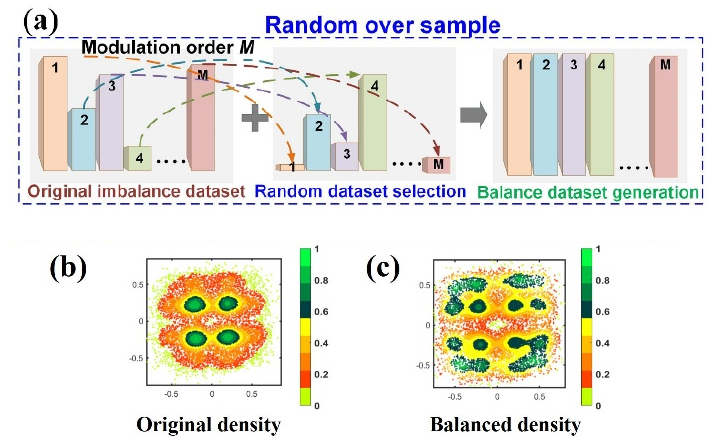
Figure 2. ( a ) Random oversampling principle for PS-m-QAM. The density of ( b ) original received PS-16QAM signals and ( c ) balance PS-16QAM signals. Color Bars: (Green: High Density, Orange Yellow: Regular Density, Bright Yellow: Sparse Density).